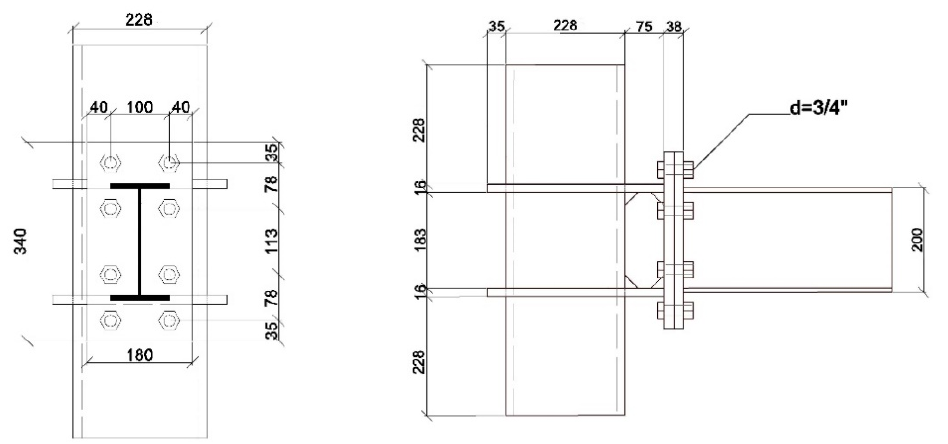
Figure 4. Details of end-plate [mm] and lateral view of EP-HSS moment connection [mm].